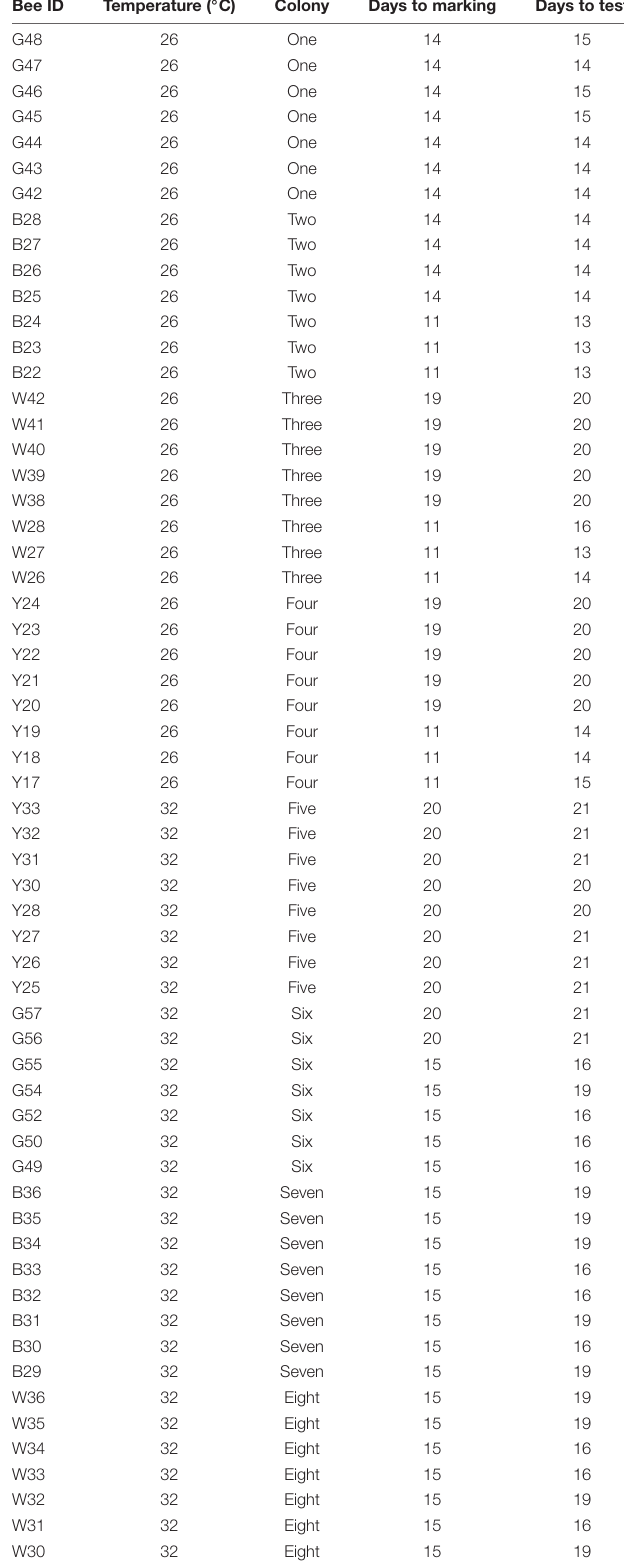
TABLE 1 | The number of days each bee spent at treatment temperatures before being marked and subjected to behavioural tests. Bee